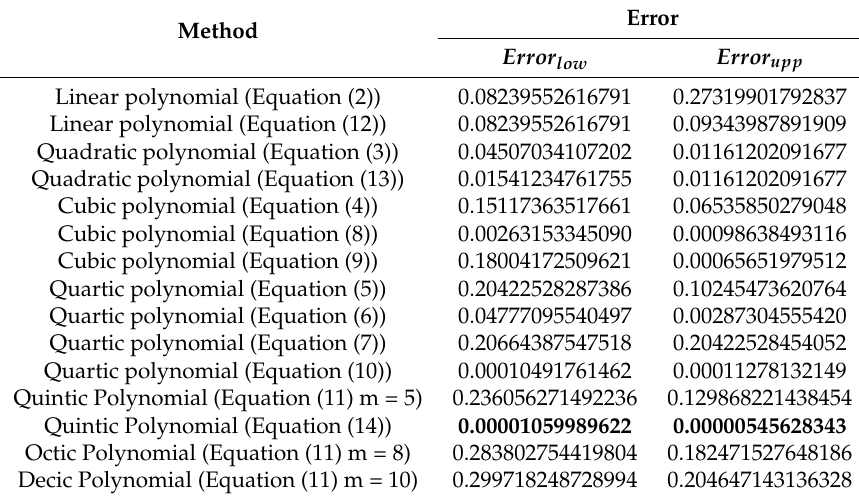
Table 1. Maximum errors from different